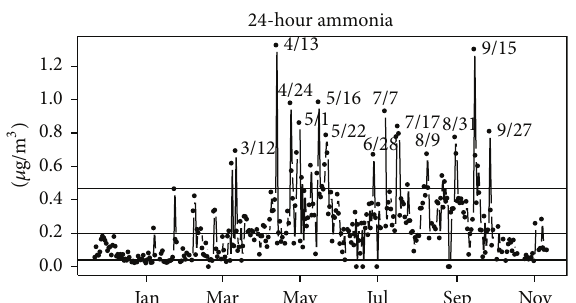
Figure 10: Observed 24-hour average concentrations of ammonia at thecoresitefromNovember2008toNovember2009.Thehorizontal lines are the 10th, 50th, and 90th percentiles. Many peak values are labeled with